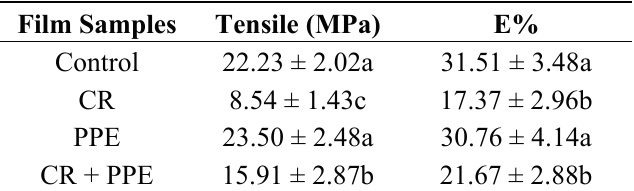
Table 2. Tensile strength and percentage elongation at break for chitosan films incorporated with pomegranate peel extract and